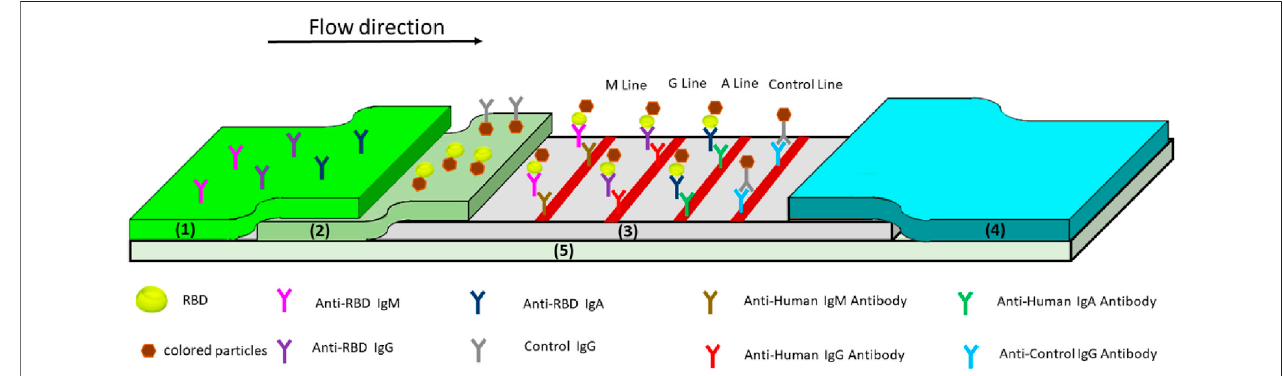
FIGURE 1 | Schematic of the lateral fl ow immunoassay for testing anti-SARS-COV-2 antibodies (Li, Yi et al., 2020). (1) Sample pad, (2) conjugate release pad, (3) membrane with immobilized antibodies, (4) adsorbent pad, and (5) adhesive